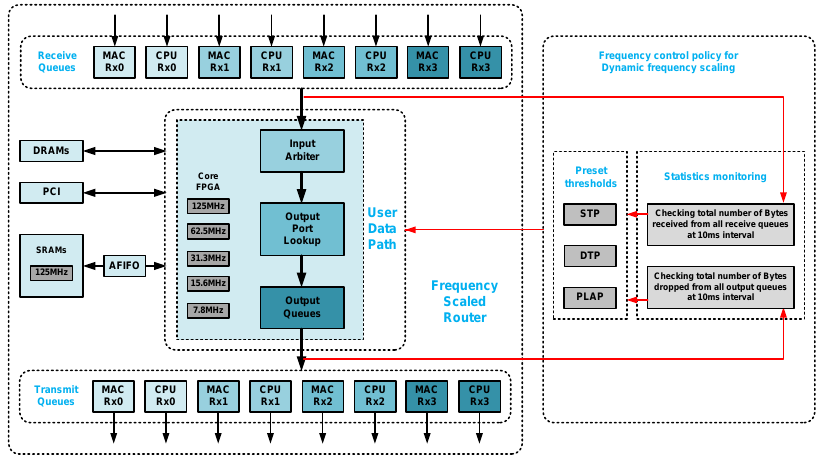
Figure 3. Implementation of dynamic frequency scaling on the frequency-scaled router